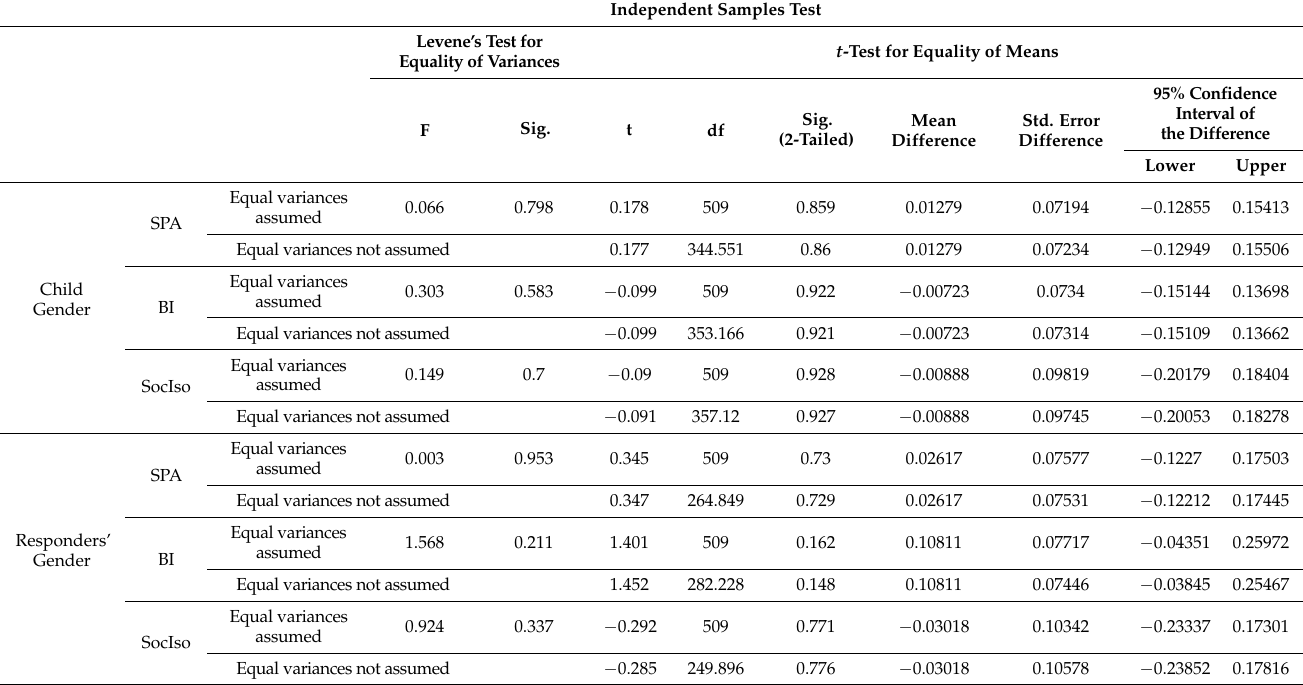
Table 12. Independent sample test, Levene’s Test, and t-test for responder and child gender. Independent Samples